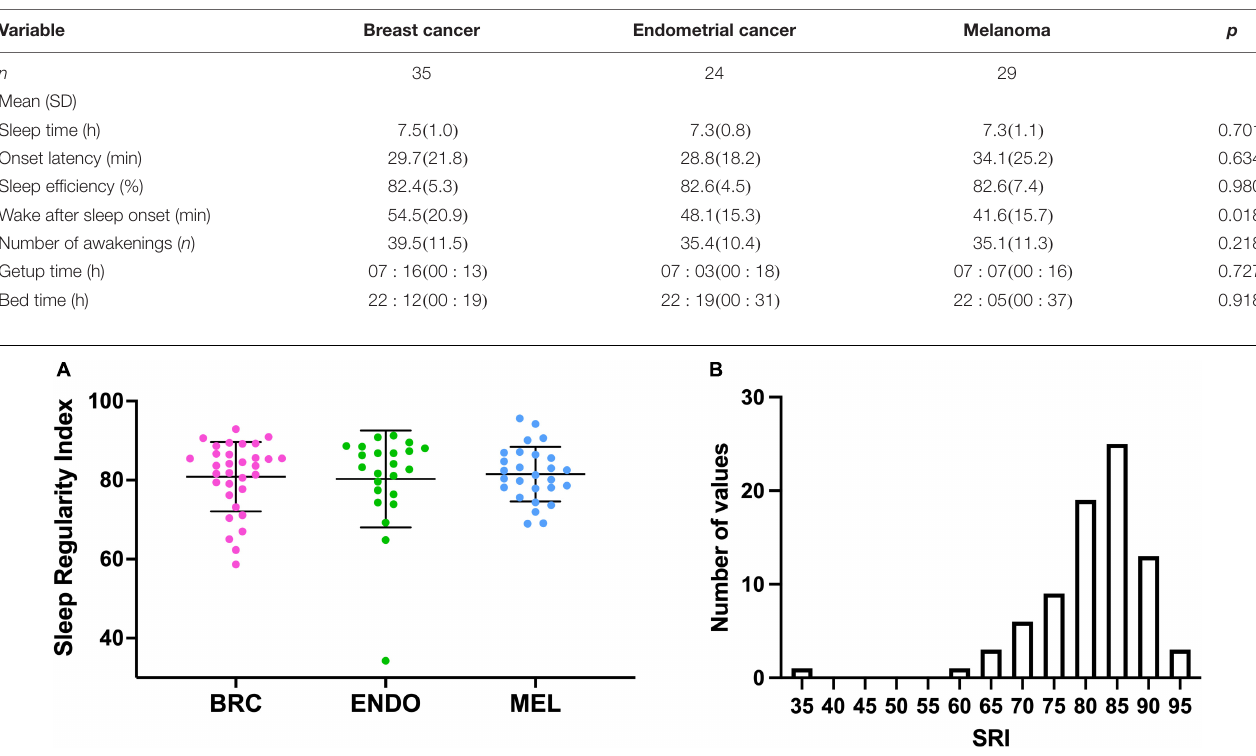
FIGURE 1 | (A) Sleep Regularity Index (SRI) values for individual cancer patients (dots) by cancer cohort. BRC (pink), breast cancer, ENDO (green), endometrial cancer and MEL (blue), Melanoma. Bars indicate mean (SD). (B) Frequency histogram for SRI for all of the cancer cohorts.